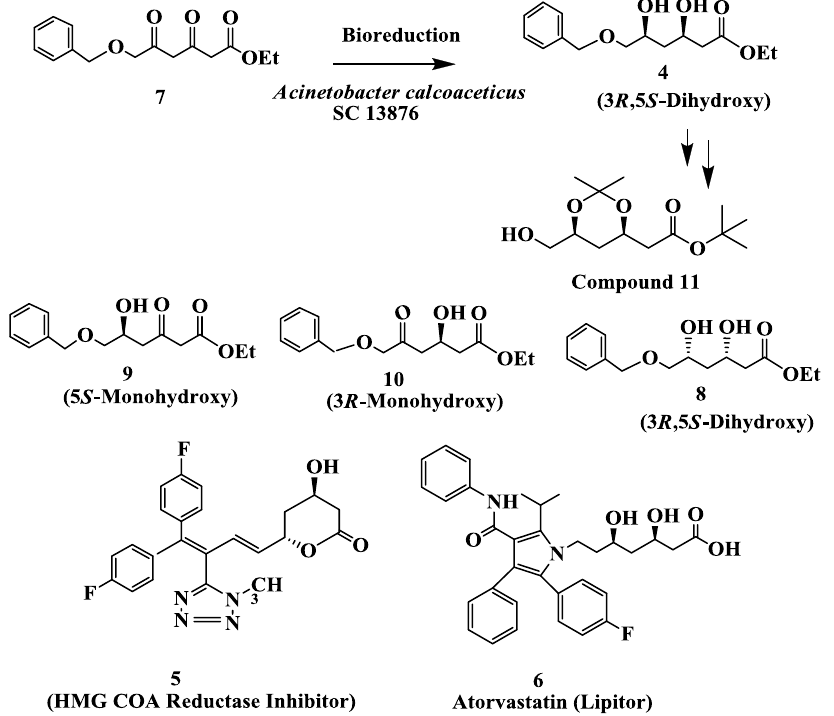
Figure 2. Cholesterol lowering agents: Enzymatic preparation of (3 S ,5 R )-dihydroxy-6- (benzyloxy) hexanoic acid, ethyl